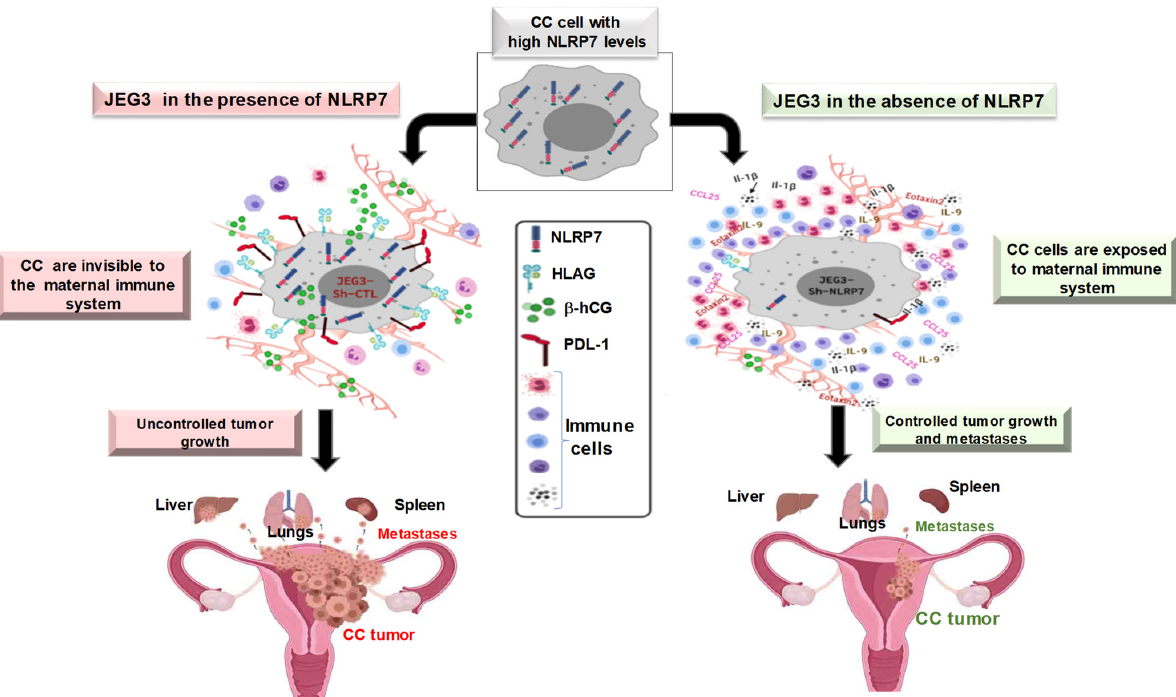
Figure 2. Proposed model for the role of NLRP7 protein in the development of gestational chori- ocarcinoma.